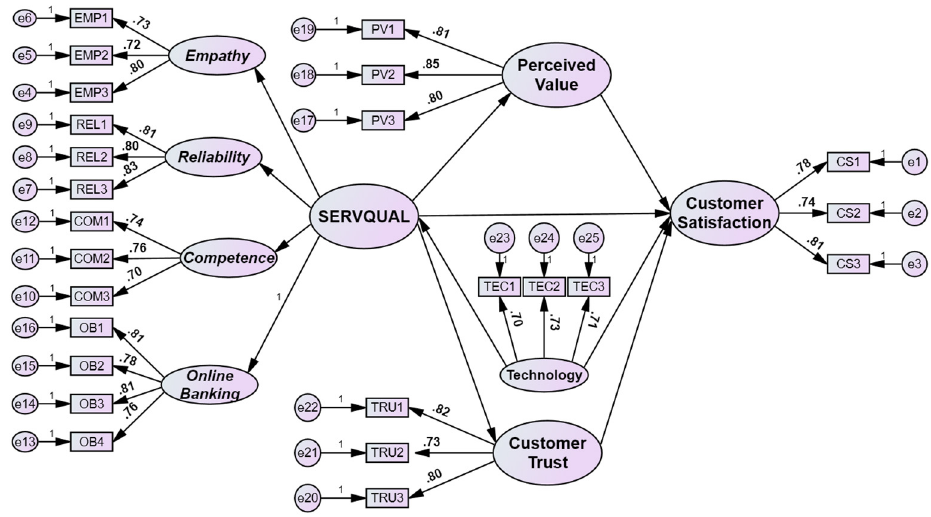
Fig. 1. Graphical (AMOS) representation of structural model of the